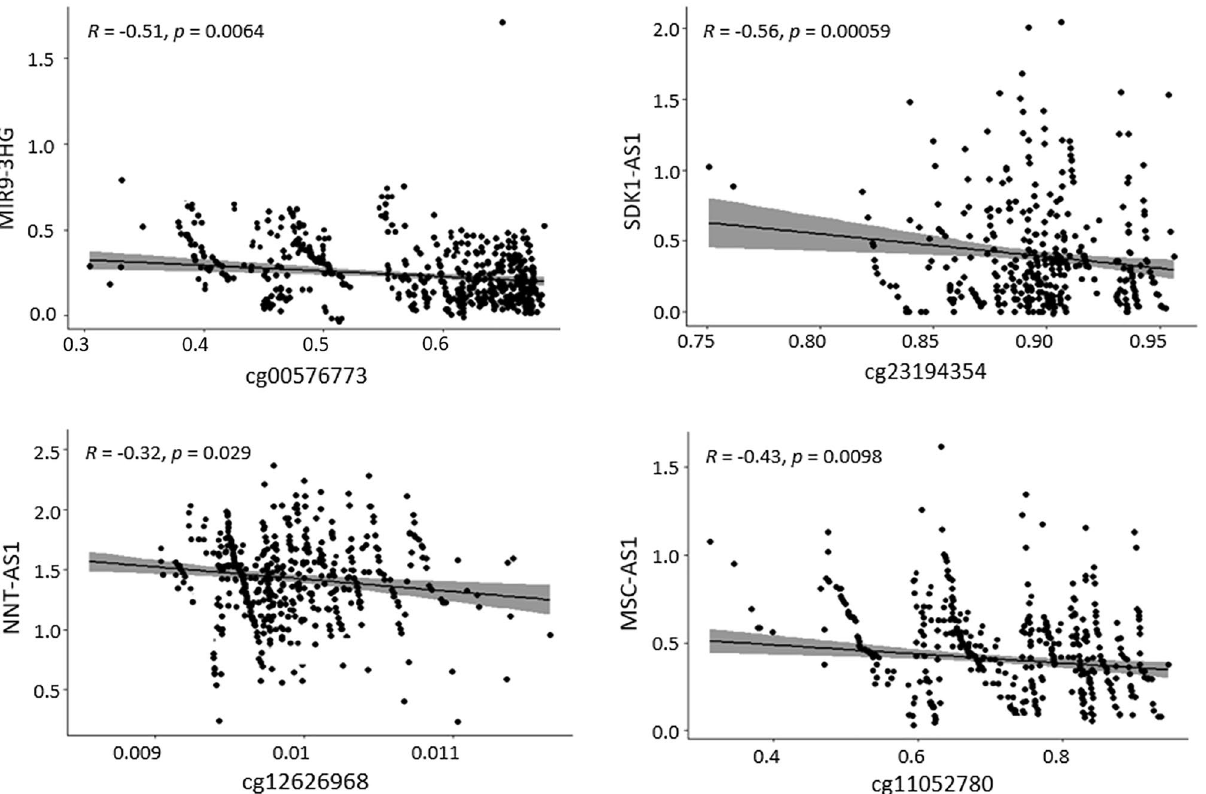
Figure 4. Correlation between the DMCs (cg00576773, cg23194354, cg12626968, and cg11052780) and the expression of lncRNAs (MIR9-3HG, SDK1-AS1, NNT-AS1, and MSC-AS1) in matched samples. The beta values of the DMCs are depicted in X-axis and the expression (FPKM) values of lncRNAs are depicted in Y-axis. R and p indicate the Spearman’s correlation coefficient and the p-values derived from Spearman’s correlation, respectively.